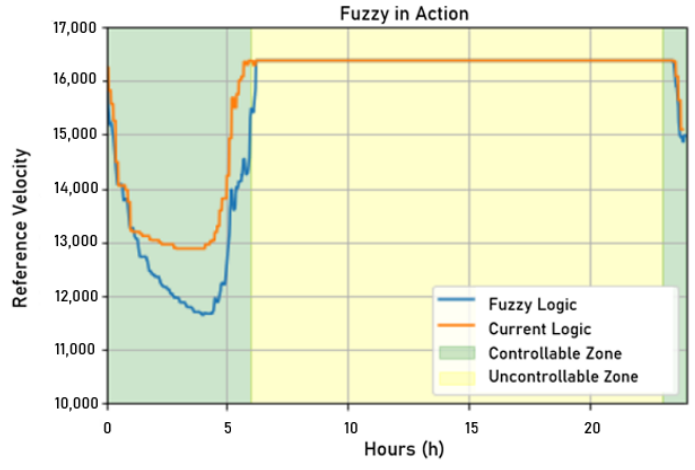
Figure 27. Frequency measured on the first day when applying fuzzy control. Source: author.